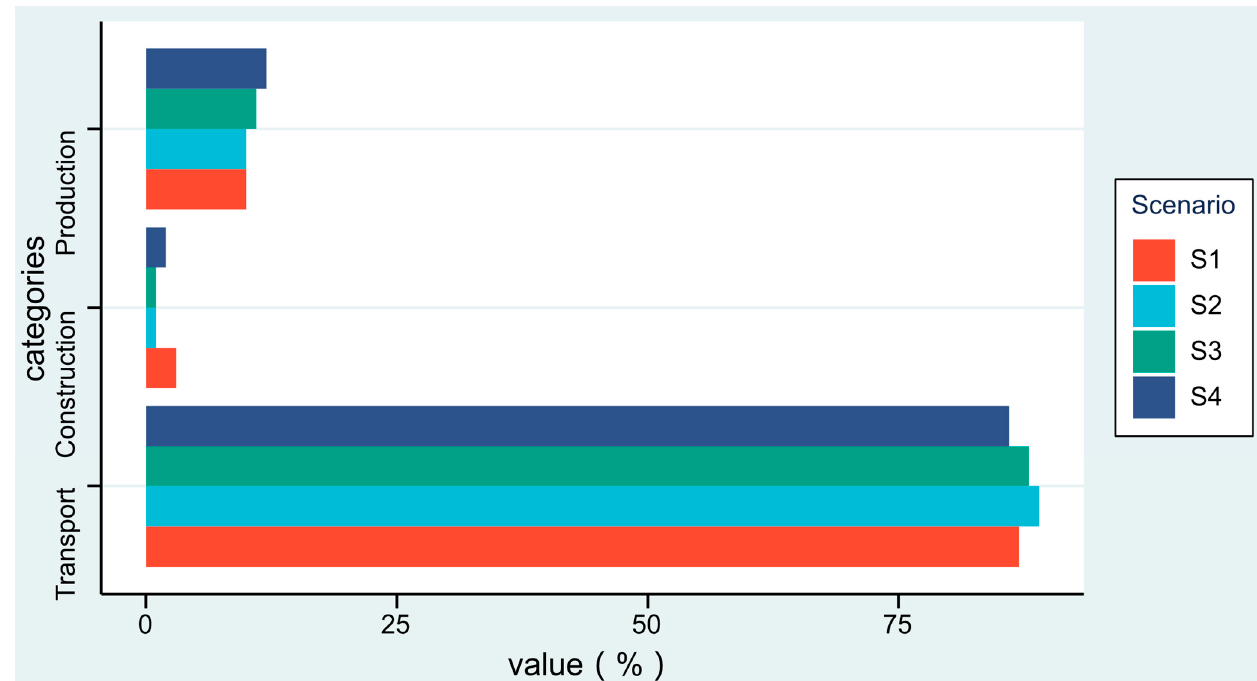
Figure 3. Carbon emission of each part.